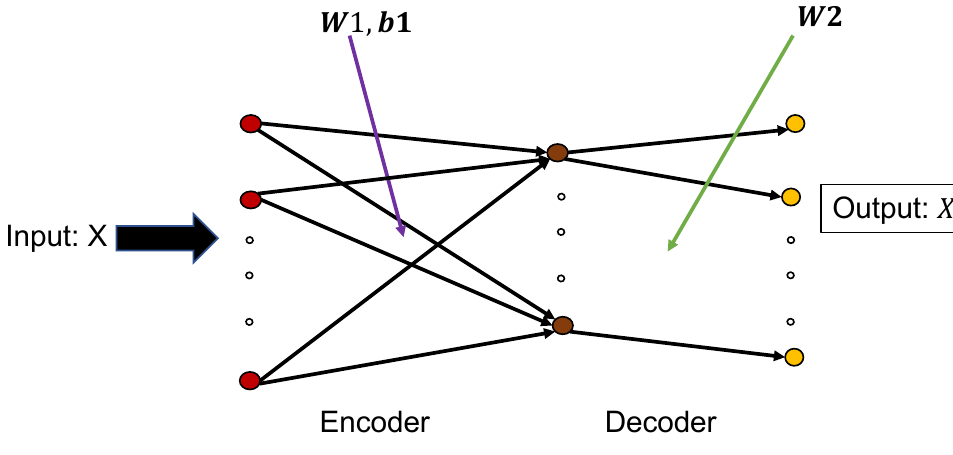
Figure 2. A single autoencoder network.